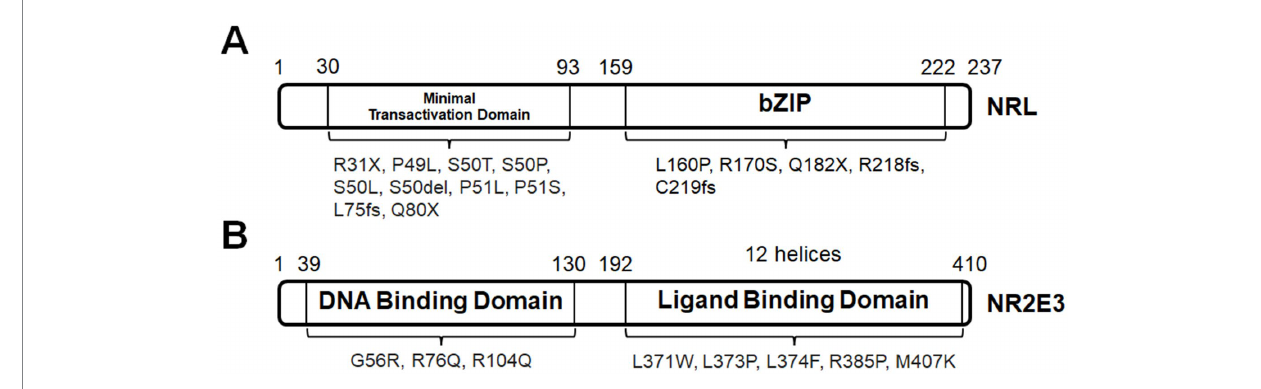
FIGURE 4 (A) NRL protein domains and associated mutations. (B) NR2E3 protein domains and associated